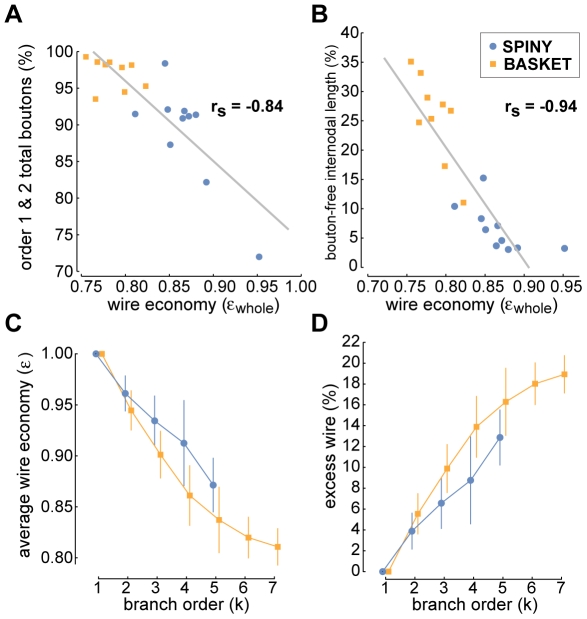
Excess axonal wire originates from nature of bouton distribution, ‘bouton-free’ internodal length, and branching complexity.(A) Whole arbor wire economy was negatively correlated with the proportion of boutons on first- and second-order branches (Spearman rank correlation, rs = −0.84, p<10−6, one-sided; linear regression (solid grey line), slope  = −109.21, intercept  = 183.35). (B) Whole arbor wire economy was strongly negatively correlated with the proportion of internodal wire length due to ‘bouton-free’ axonal sections (Spearman rank correlation, rs = −0.94, p<10−6, one-sided; linear regression, slope  = −1.93, intercept  = 1.75). (C) Average wire economy of axonal subtrees decreased with parent branch order towards whole arbor economy levels suggesting basket axon poorer wire economy was associated with their greater degree of branching complexity. (D) Percentage excess wire grew with branch order towards whole arbor levels implying each level of branching costs excess wire length in neocortical axons.